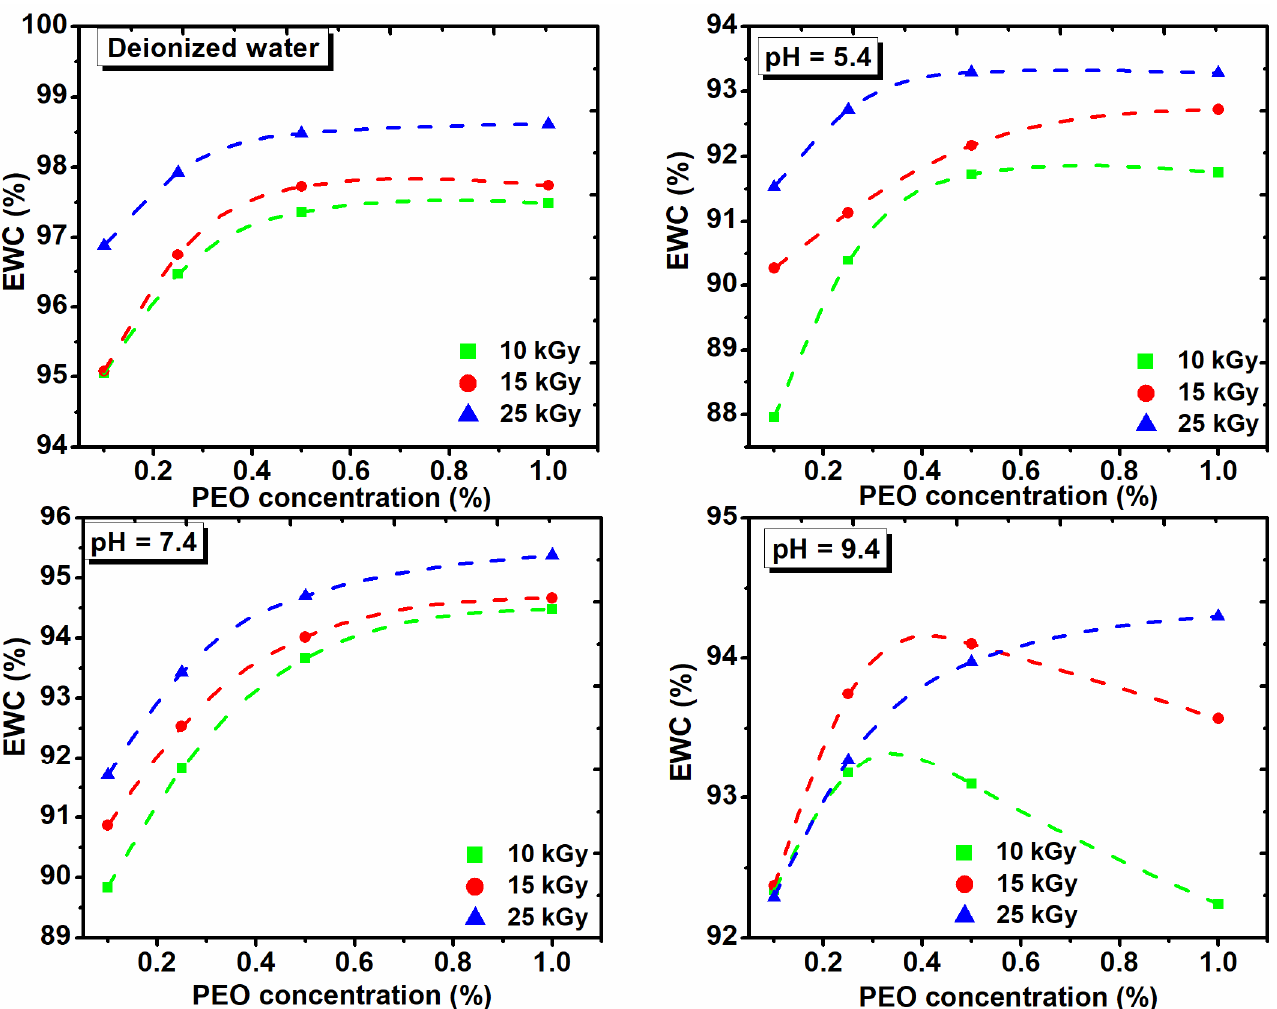
Figure 7. The effect of PEO concentration on the equilibrium water content in deionized water and solutions with different pH and absorbed dose.